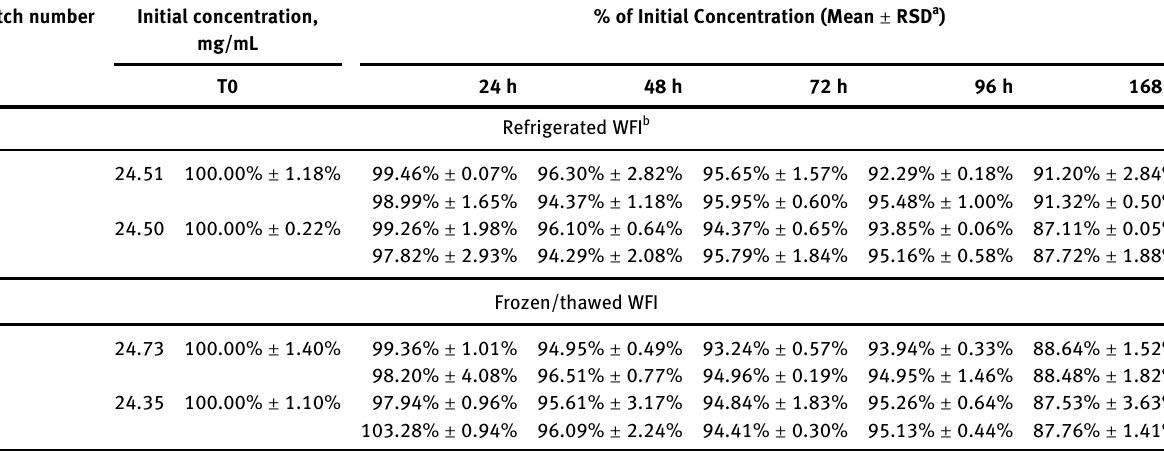
Drugconcentrationsinsamplestakenat timezero weredesignatedas  % (n=  ). Sampleswerepreparedinduplicate foreachsyringe. a RSD, relative standard deviation; b WFI, water for